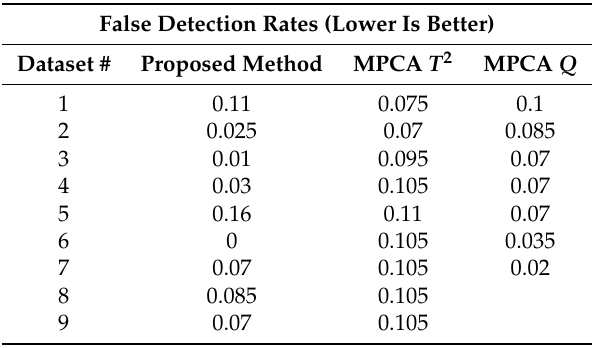
Table 8. False detection rates for the PenSim data. False Detection Rates (Lower Is Better)